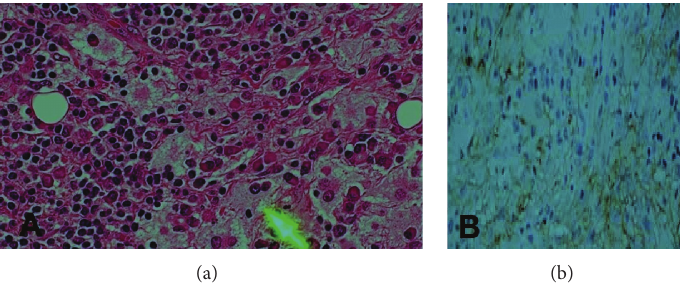
Figure 2: Biopsy showing (a) large histiocytes found with vesicular nuclei and emperipolesis. And (b) immunohistochemistry demonstrated the positivity for S-100, CD68, and CD45 and negativity for CD1a, consistent with the diagnosis of extra-nodal RDD.